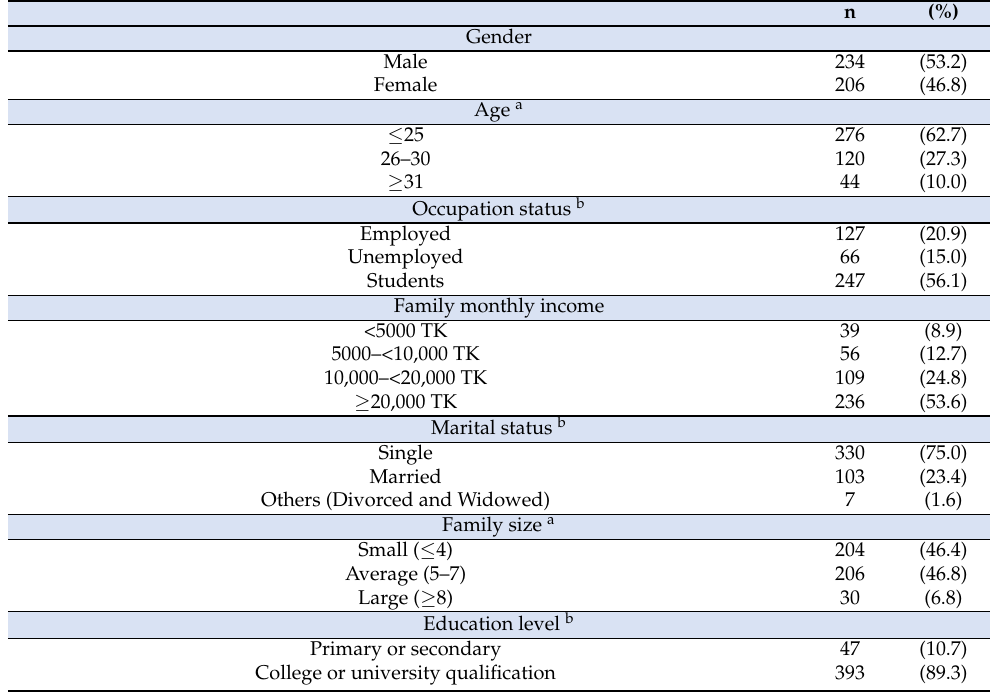
Table 1. Distribution of sociodemographic characteristics, N =